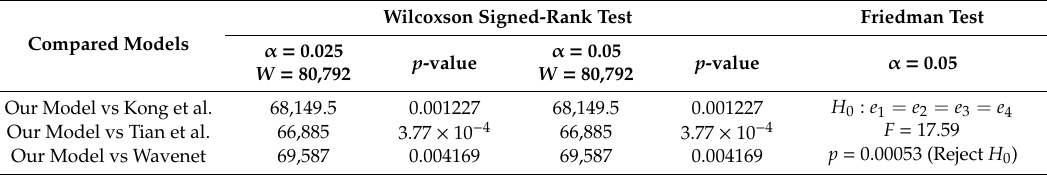
Table 8. Result of the Wilcoxon signed-rank test and Friedman test using ISO-NE testing dataset 1. Compared Models